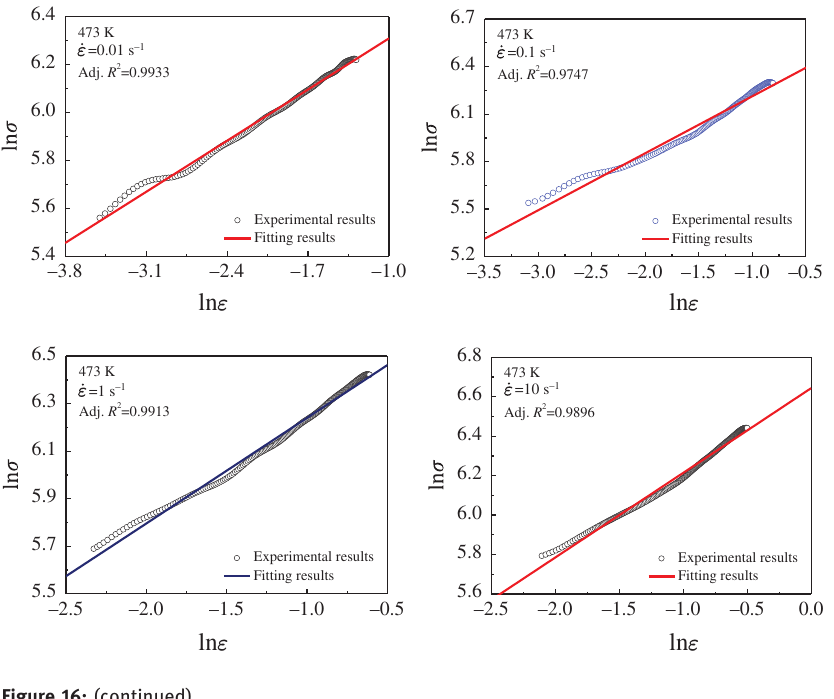
f 3 ð _ ε , T Þ at low temperature region for ultra-high-strength steel was conducted and as shown in Table 16.